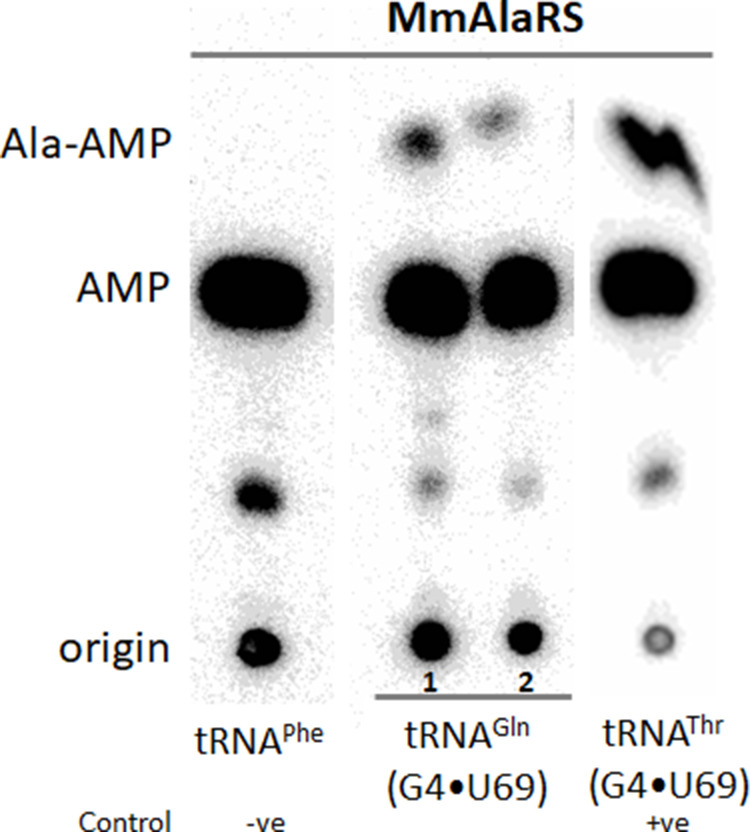
Aminoacylation of S. rosetta tRNAGln.TLC of S1 digested aminoacylation reaction products showing aminoacylation of tRNAGln(G4•U69) by M. musculus AlaRS (1 and 2 represent the two clones of tRNAGln). tRNAPhe (does not have either G4•U69 nor G3•U70) and tRNAThr(G4•U69) are used as negative and positive control respectively.